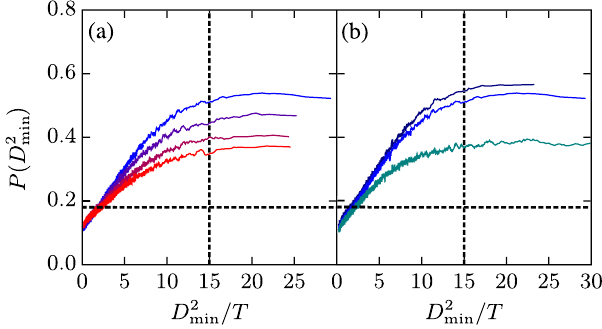
FIG. 2. The probability of a particle residing in a soft spot as a function of its D 2 value. Panel (a) shows a comparison of the min temperatures studied from T ¼ 0 . 1 (in blue) to T ¼ 0 . 4 (in red) at a strain rate of _ γ ¼ 10 − 4 , and panel (b) shows a comparison of strain rates studied from _ γ ¼ 10 − 5 (in dark blue) to _ γ ¼ 10 − 3 (in green) at a temperature of T ¼ 0 . 1 . In all cases, we see that the ≃ 15 T probability increases with D 2 until some threshold D 2 min th (vertical dashed line) at which point the probability reaches some plateau value P (cid:2) . The soft-spot density ρ is marked by a SS horizontal dashed